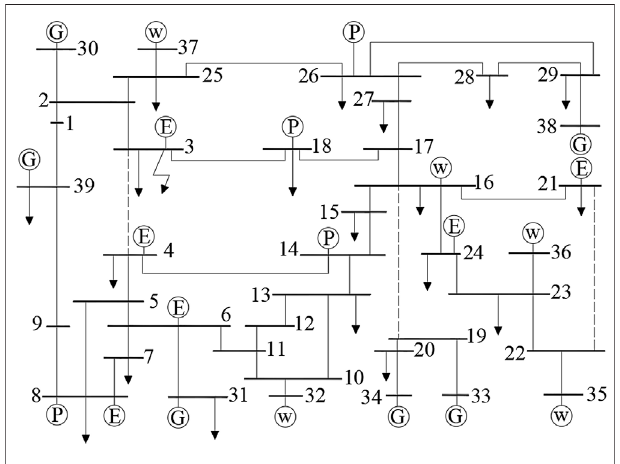
FIGURE 3 | Power grid structure diagram with multi-energy